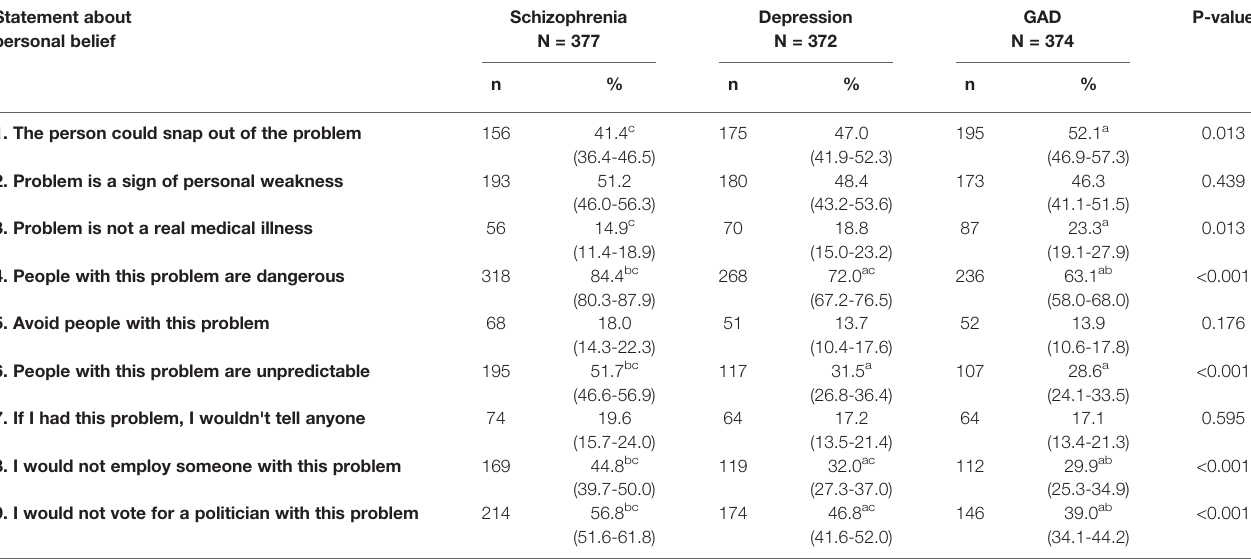
TABLE 2 | Percentage (and 95% CI) of participants who “ agree ” or “ strongly agree ” with statements about their own attitudes towards the person in the vignette.